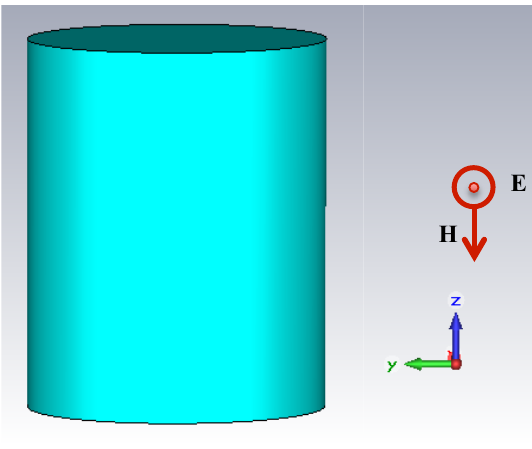
Fig.6. The schematic of the elliptical object.